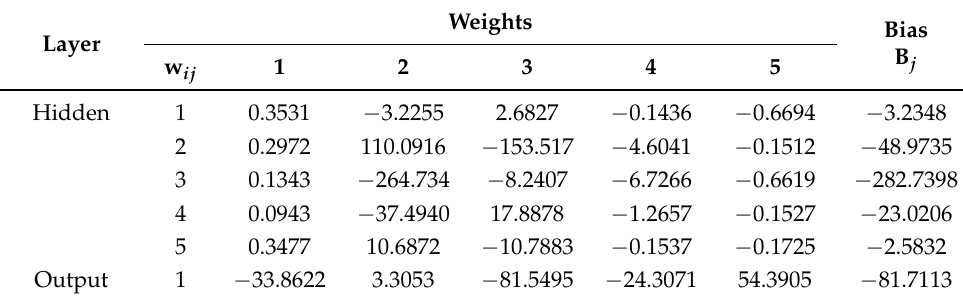
Table 7. Weights and biases for R 3.2 model of RTFO binders.